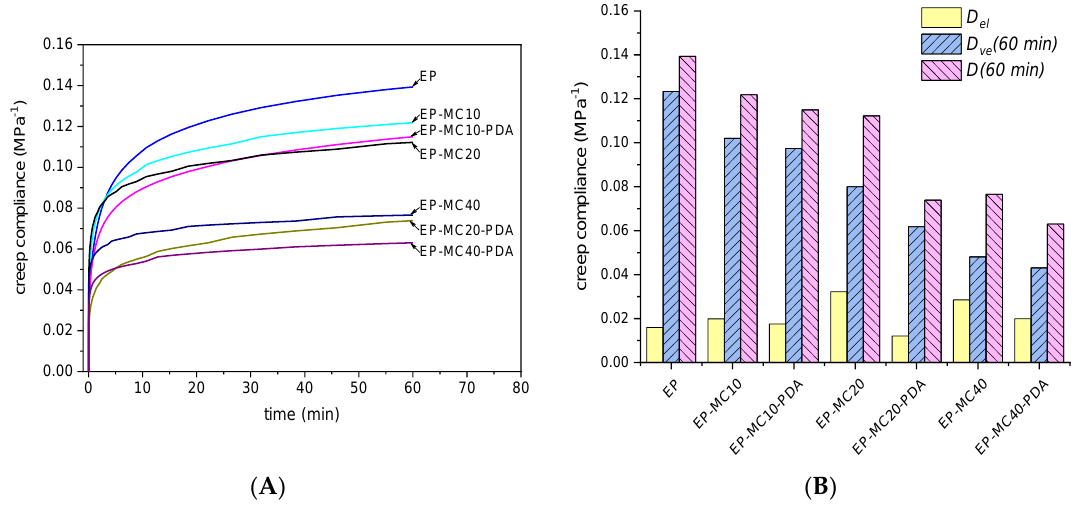
Figure 10. Results of creep tests on the prepared composites. ( A ) Creep compliance as a function of time; ( B ) initial (elastic) compliance ( 𝐷 𝑒𝑙 ), viscoelastic component of the compliance at 60 min ( 𝐷 𝑣𝑒 (60𝑚𝑖𝑛) ), and total final creep compliance at the end of the test ( 𝐷(60𝑚𝑖𝑛) ).